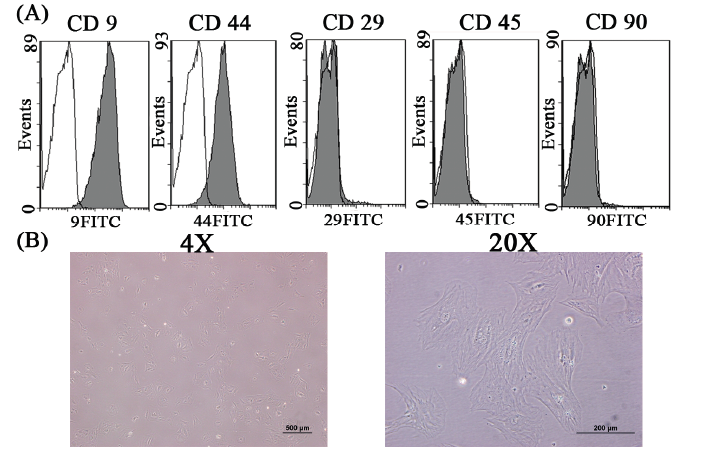
Figure 1. The identification of Ligamentum flavum cells by flow cytometery ( A ) and the morphology of LF cells cultivated on culture dish ( B